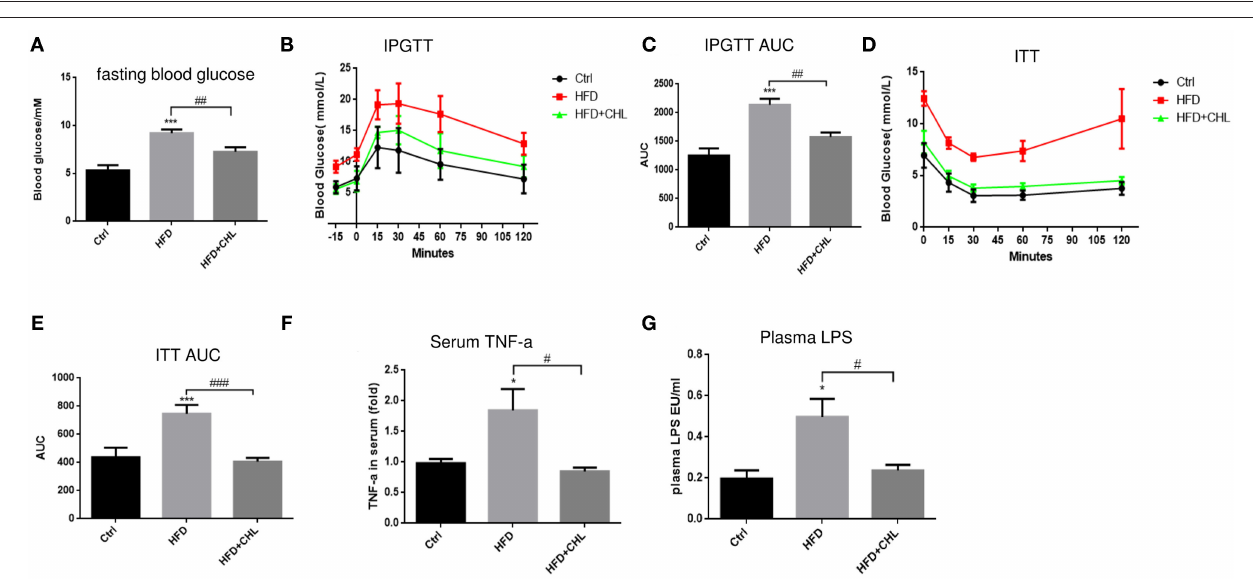
FIGURE 6 | CHL improves insulin responsiveness and liver functions of the mice fed with an HFD. (A) Fasting blood glucose was measured by the mice as mentioned in the section, Materials and methods. (B) Intraperitoneal glucose tolerance test (IPGTT) of the three groups of mice. (C) Aura under the curve (AUC) of IPGTT was determined. (D) The insulin tolerance test (ITT) was measured for the three groups of mice. (E) AUC of ITT was determined. (F) Serum ALT levels were determined by ELISA analysis. (G) Plasma lipopolysaccharide (LPS) was determined by Limulus amebocyte lysate (LAL) analysis and n = 6–8 for each group. Values are mean ± SEM; * p < 0.05, *** p < 0.001 vs. Ctrl group; # p < 0.05, ## p < 0.01, ### p < 0.001 vs. HFD group.